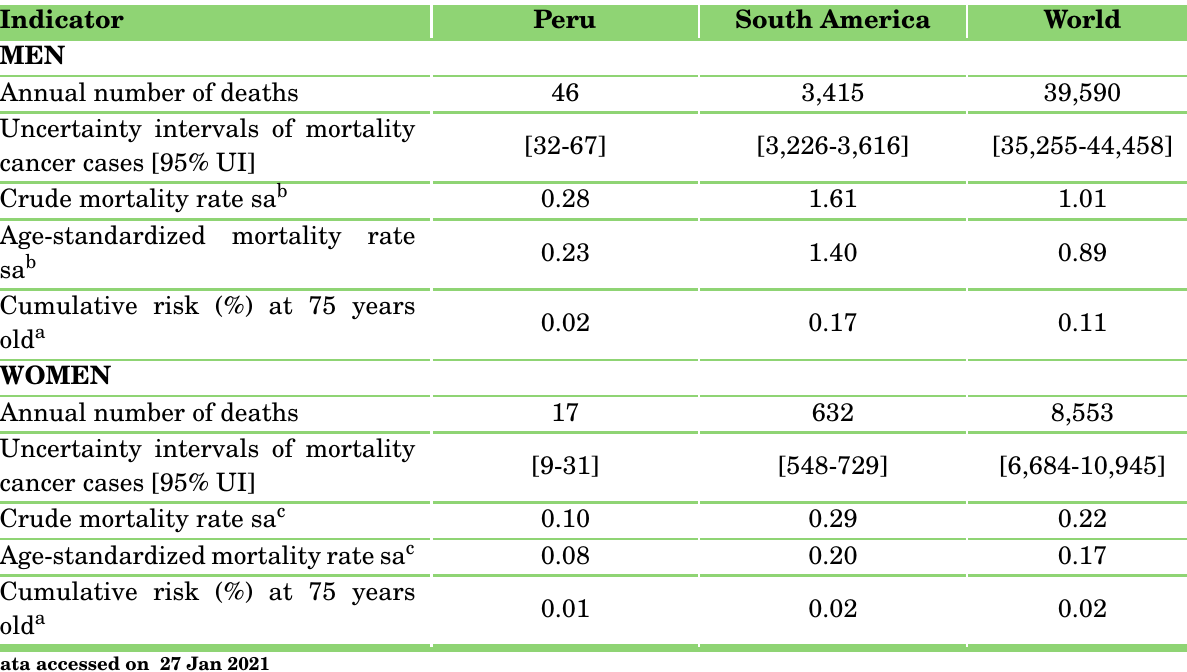
Table 16: Oropharyngeal cancer mortality in Peru (estimates for 2020) Indicator Peru South America World